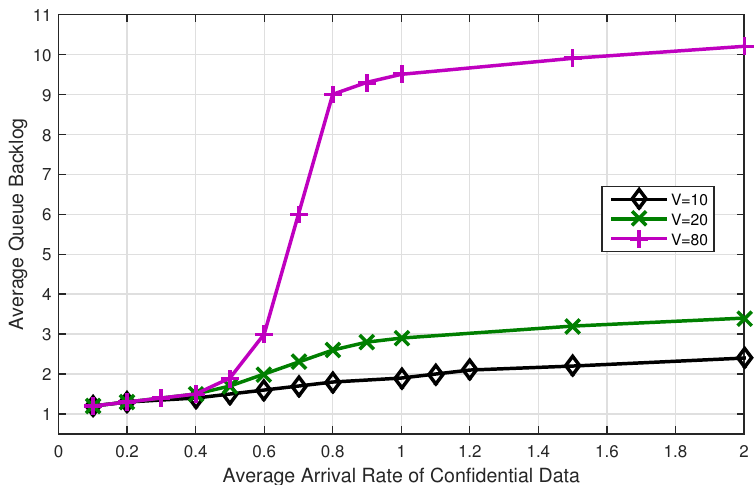
Figure 4. Average queue backlog with varying confidential data arrival